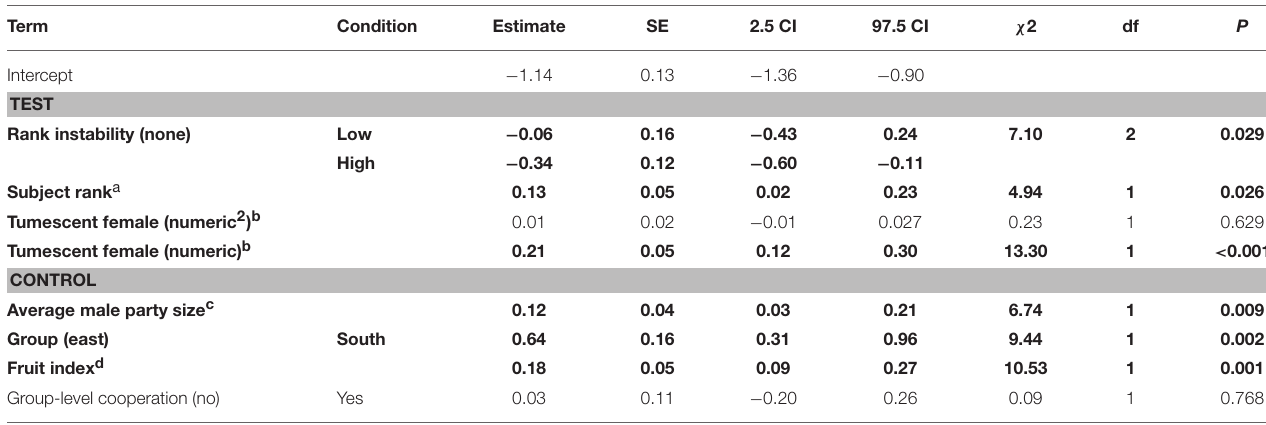
TABLE 4 | Effect of rank instability, subject rank and number of fully tumescent parous females present (tumescent female) on the number of aggressions given by male chimpanzees (model 2.1). Term